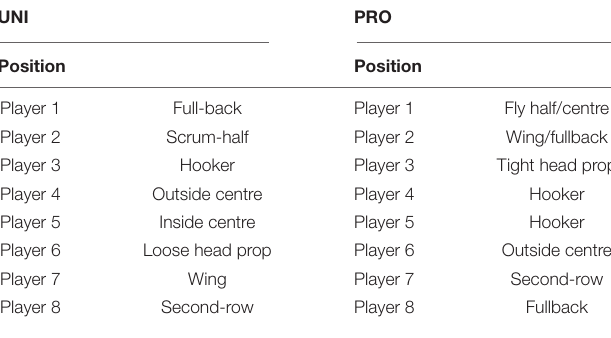
TABLE 1 | Player positions by